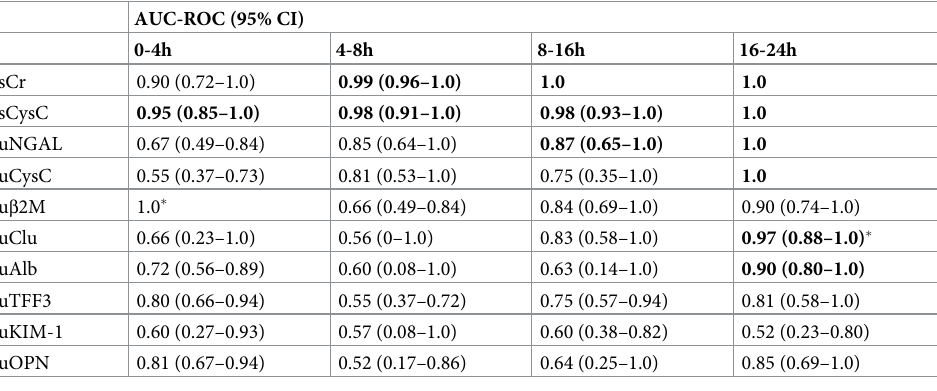
Table 2. The area under the curve of the receiver operator characteristic (AUC-ROC) curve (with 95% confidence intervals) for biomarker concentrations predicting moderate/severe AKI (AKI stage 2–3) versus none or mild AKI (AKI stage 1), in each of the four time periods within the first 24h of the